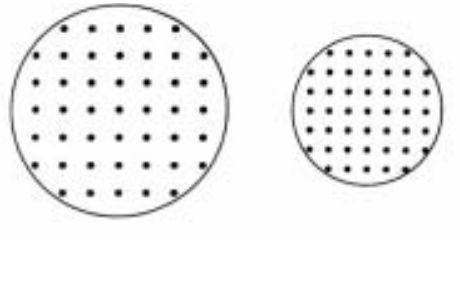
Figure 2 The relationship between density and average distance between functions, symbolized with dots within circles of different